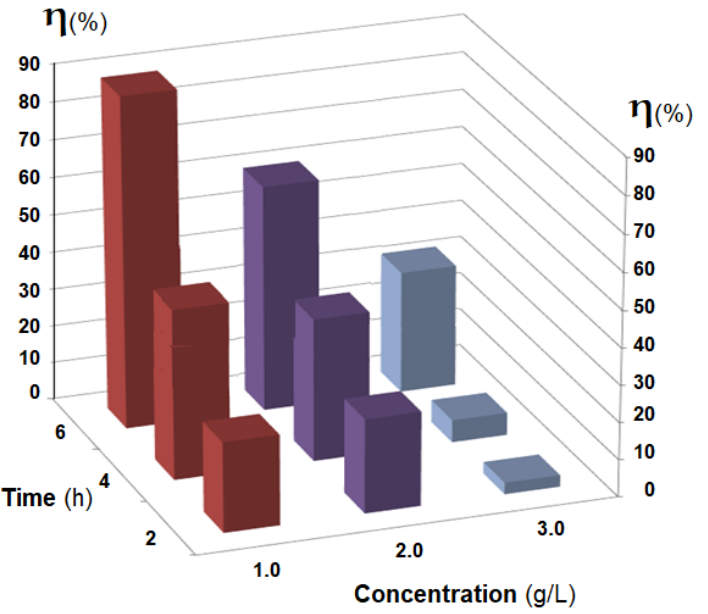
Figure 15. The influence, as a function of operating time (h), of p- nitrophenol concentration (g/L) on conversion ( η %) to reduction of p- nitrophenol in tert- butyl alcohol solution.